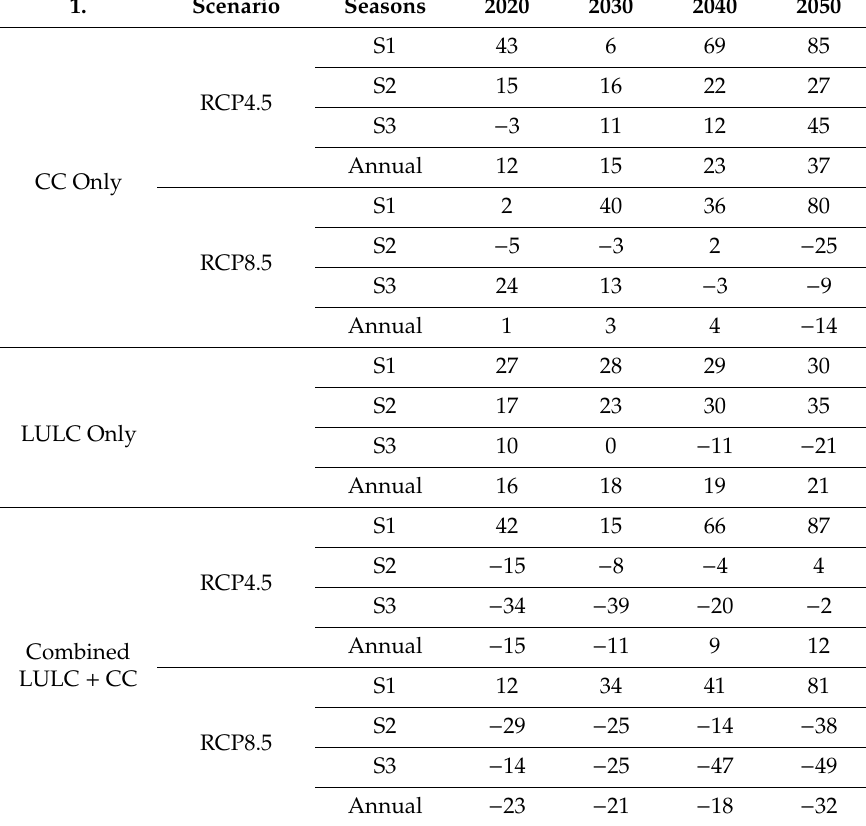
Table 7. Percentage change in river runo ff due to projected changes in climate only, land use / cover (LULC) only, and combination of both changes in Kathmandu Valley